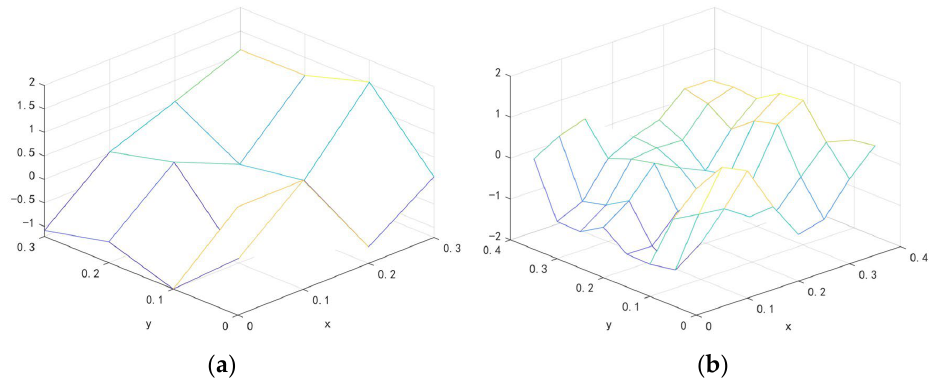
Figure 4. Original and regenerated two-dimensional data: ( a ) Original two-dimensional discrete data; ( b ) regenerated two-dimensional discrete data.